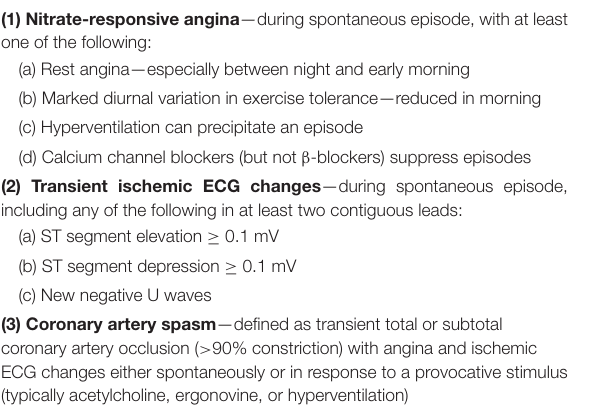
TABLE 2 | Diagnostic criteria for epicardial spasm.